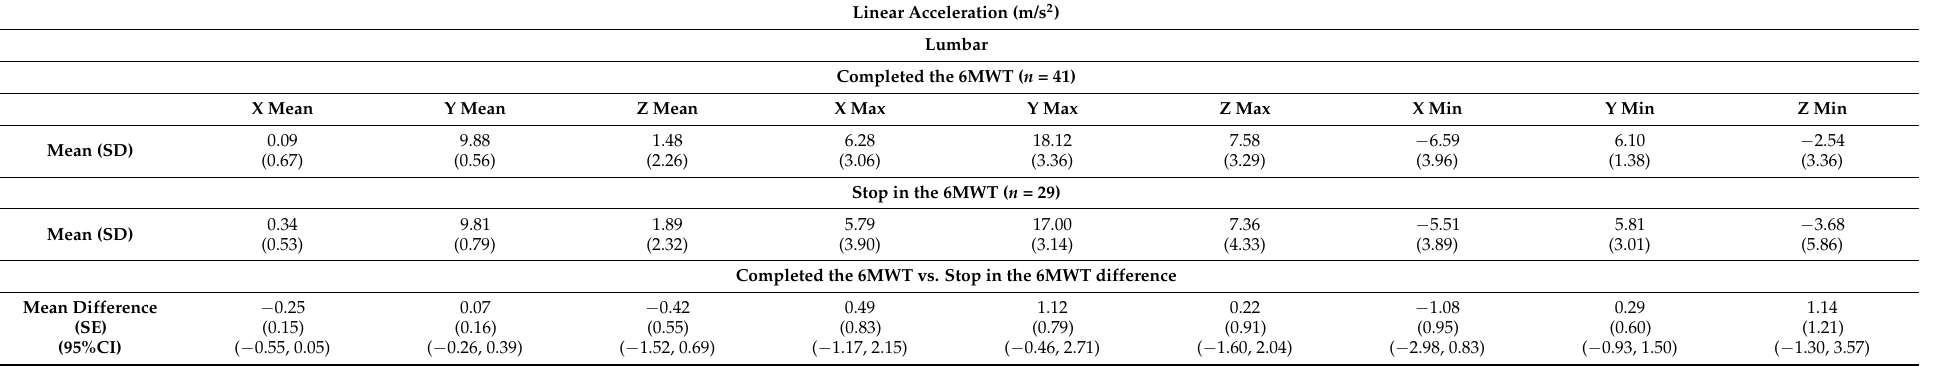
Table 4. Kinematic outcomes differences in the three dimensions between patients who completed the 6MWT and patients who could not finish the